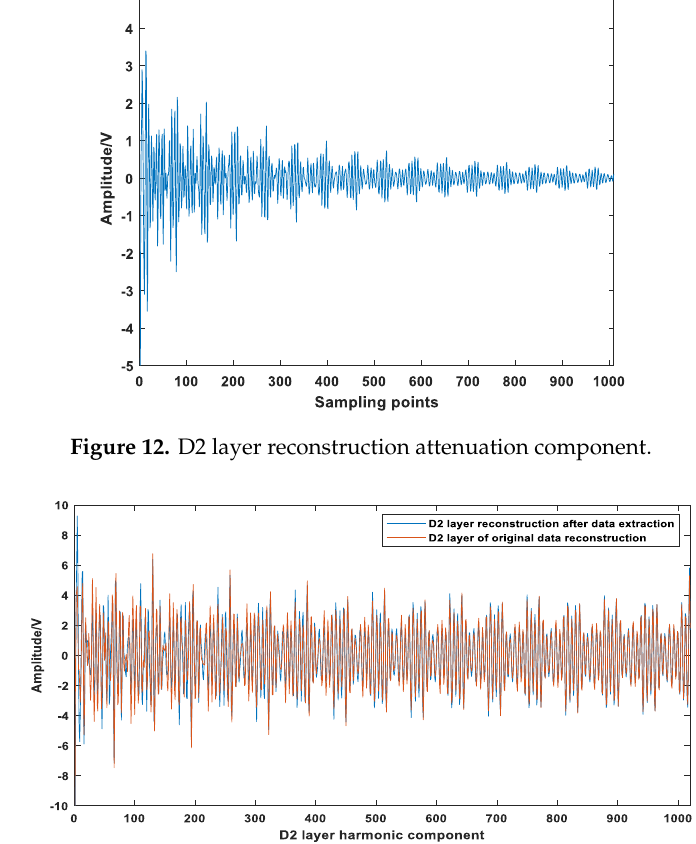
Figure-13. D2 layer reconstruction waveform compared with the original waveform.